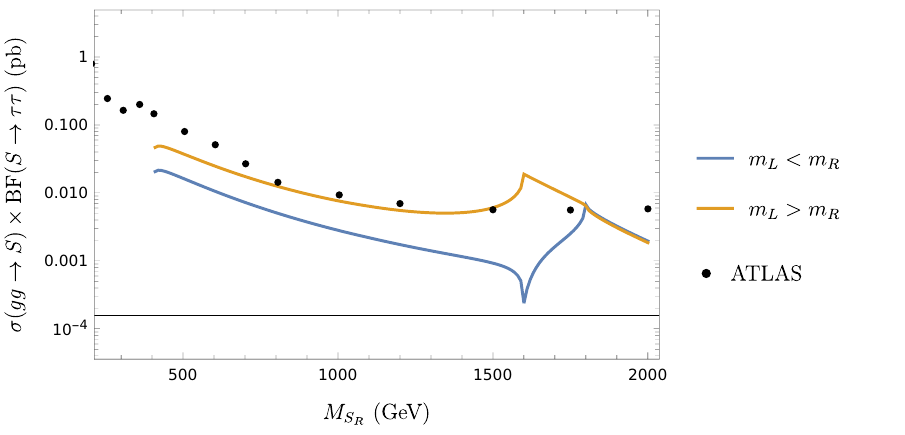
Figure 9 . The scalar singlet production cross section via gluon fusion, in the case of (a) a lighter left stop, (b) a lighter right stop, and (c) degenerate left and right stops at 850 GeV, with all other parameters chosen as in benchmark B2.